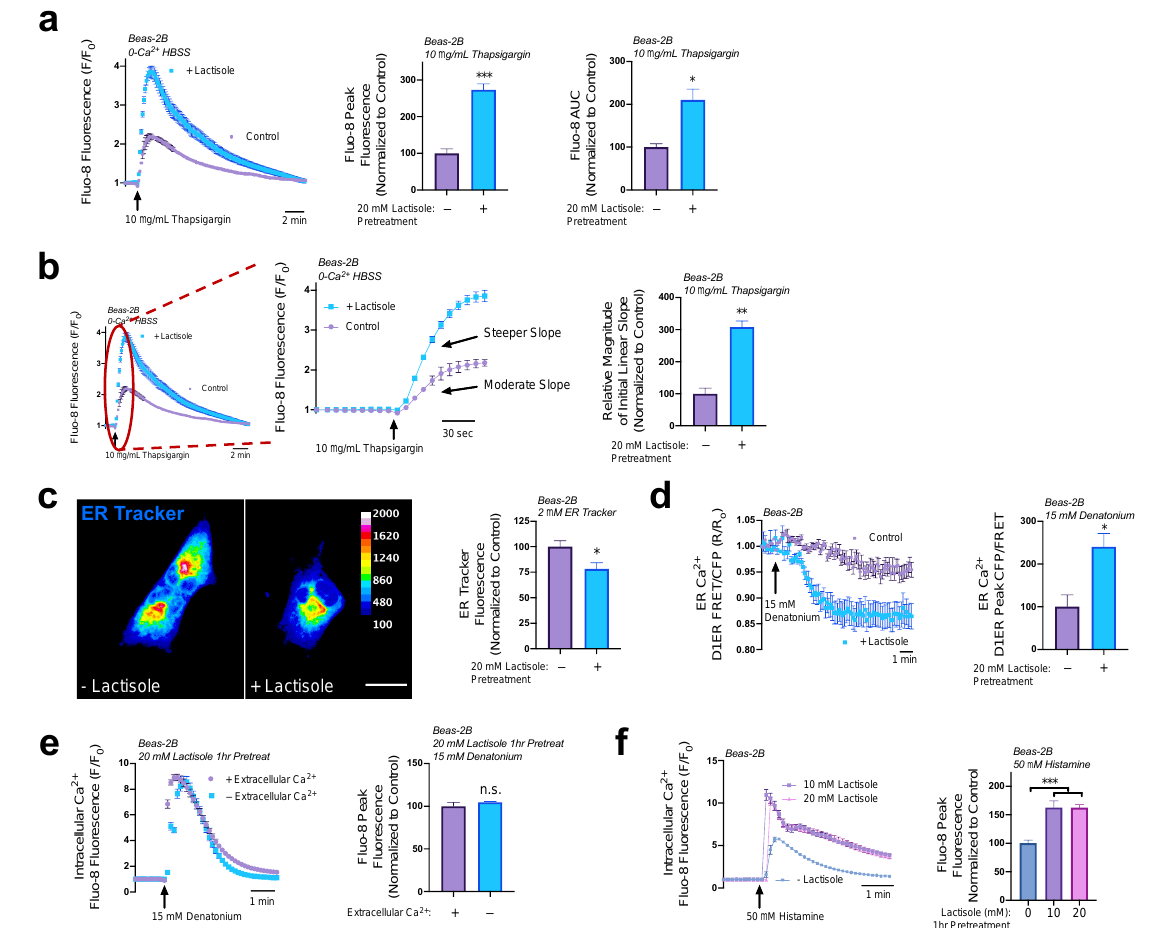
Figure 2. Lactisole increases ER Ca 2+ content and size. ( a ) The 20 mM lactisole 1 h pretreatment increases peak Ca 2+ release by 275% and ER Ca 2+ content by 200%. ( b ) Analyzing the initial linear slope from trace in experiment ( a ), as highlighted by red circle and enlarged in graph on the right, revealed that lactisole treatment (20 mM, 1 h) caused a 300% steeper slope relative to untreated cells. ( c ) Beas-2B cells treated with 20 mM lactisole for 1 h revealed a decrease in ER tracker fluorescence. ( d ) Beas-2Bs expressing ER Ca 2+ sensor D1ER show that denatonium treatment reduced ER Ca 2+ stores 250% with 20 mM lactisole pretreatment (1 h). ( e ) Lactisole increases denatonium-induced Ca 2+ release regardless of extracellular Ca 2+ ( f ) Both 10 and 20 mM lactisole pretreatment (1 h) increases histamine-induced Ca 2+ release by 50%. Traces are representative of ≥ 3 experiments. Bar graphs containing two comparisons were analyzed via t -test; bar graphs containing >2 comparisons were analyzed via ANOVA using Bonferroni’s post-test for multiple comparisons * p < 0.05, ** p < 0.01, *** p <